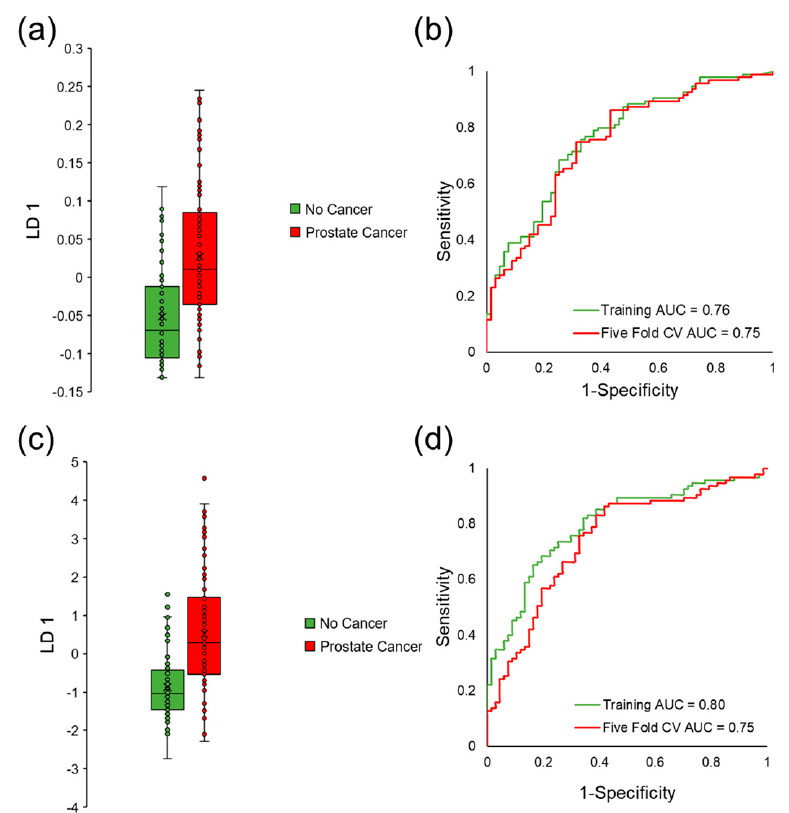
Figure 4. Supervised multivariate analysis of human urine to identify a biosignature of VOCs that could classify prostate cancer through LDA. ( a ) LD 1 scores for a model of six urinary volatiles that separates any grade of prostate cancer with ( b ) ROC AUC equal to 0.76 in the training data set and 0.75 in the cross-validated data set. ( c ) LD 1 scores for an alternative model of seven urinary VOCs that could distinguish prostate cancer with ( d ) ROC AUC equal to 0.80 in the training data and 0.75 in the cross-validated data set.